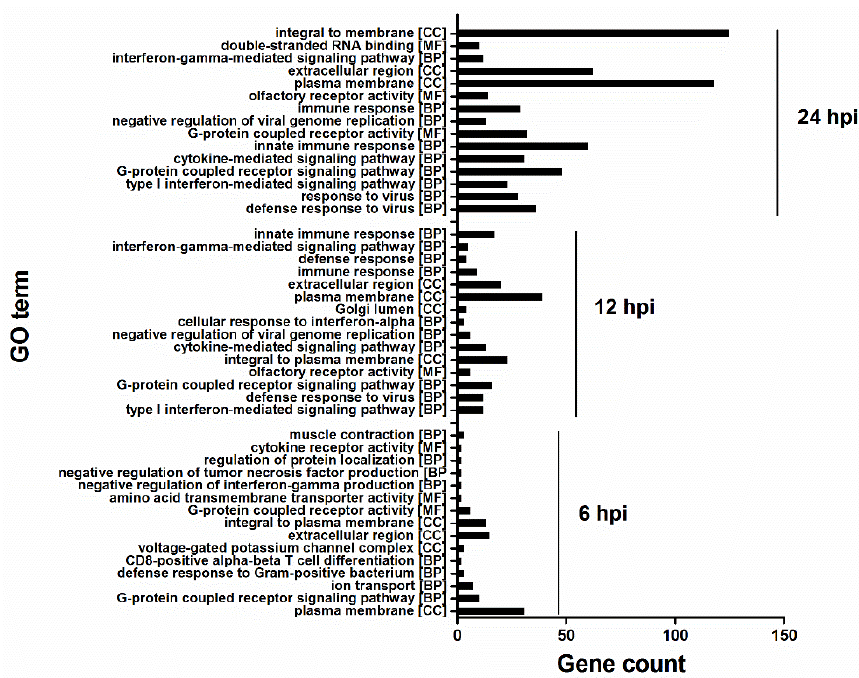
Figure 4. Significantly enriched Gene Ontology (GO) terms according to InnateDB. Gene count refers to DE genes in identified GO terms. Many categories shared the same genes. In addition, only the top 15 were shown based on the number of DE genes in GO terms.